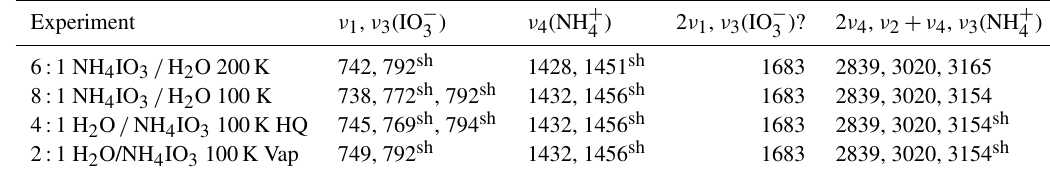
Table 1. Positions (in cm − 1 ) and assignment of the mid-IR spectra bands of the NH 4 IO 3 / H 2 O ice mixtures shown in Fig. 3. Experiment